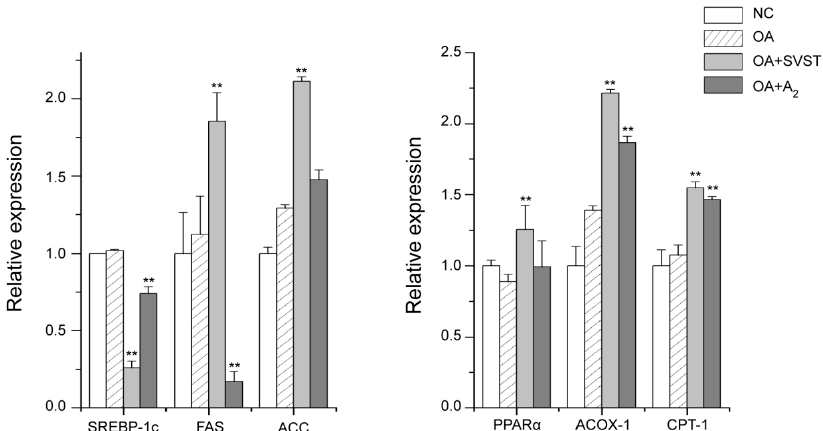
Figure 3. The relative expression of genes related to fatty acid metabolism on fatty acid synthesis genes ( SREBP-1c, FAS and ACC ) and fatty acid β -oxidation genes ( PPAR α , ACOX-1 and CPT-1 ). NC, blank control; OA, 80 µ M oleic Acid; OA + SVST, 80 µ M Oleic Acid + 10 µ M simvastatin; OA + A 2 , 80 µ M Oleic Acid + 10 µ M Oleiferasapoin A 2 . Compared to the control, ** p < 0.01.